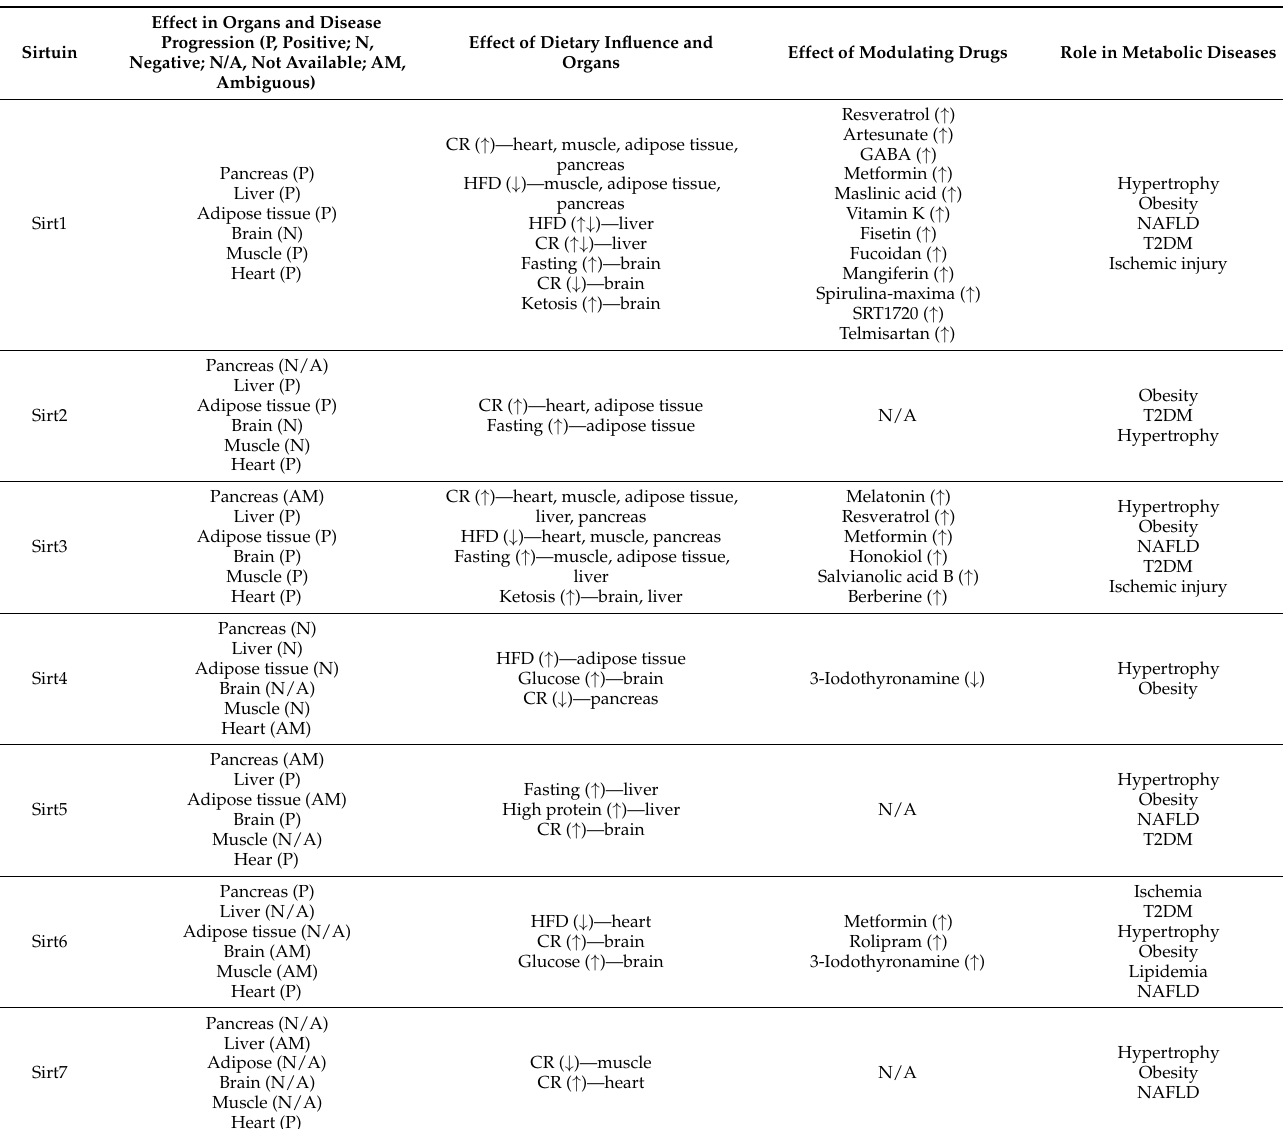
Table 7. Overview of the role of Sirtuins in metabolic